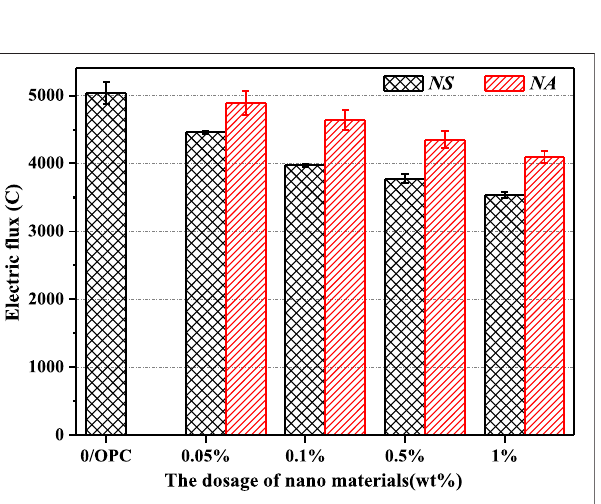
Frontiers in Materials |